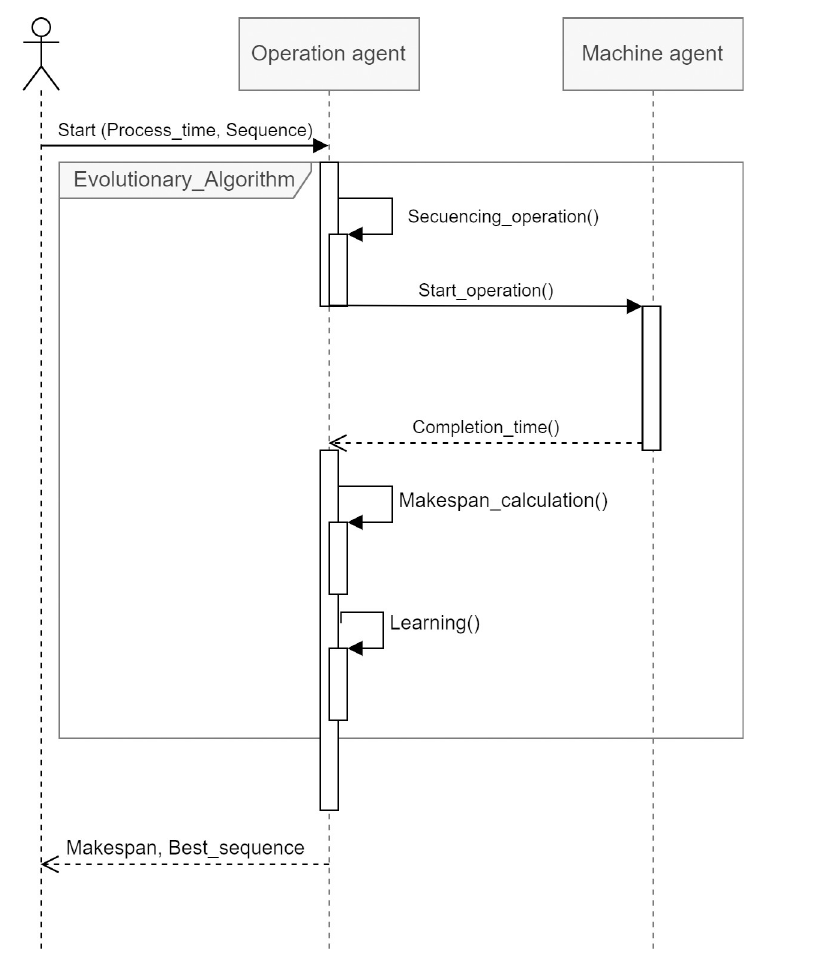
Fig 3. Diagram of the sequence for the action of the product